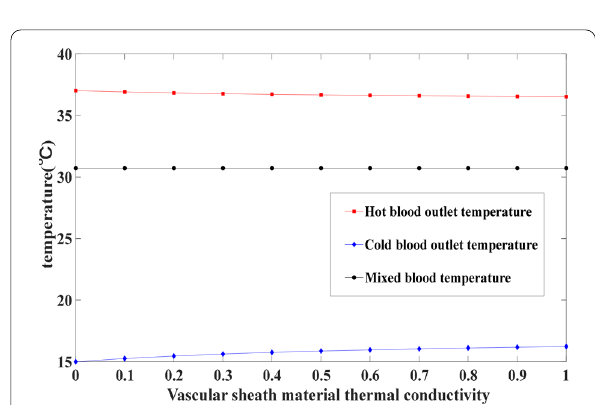
Figure 11 Output temperature trend curves influenced by vascular sheath material